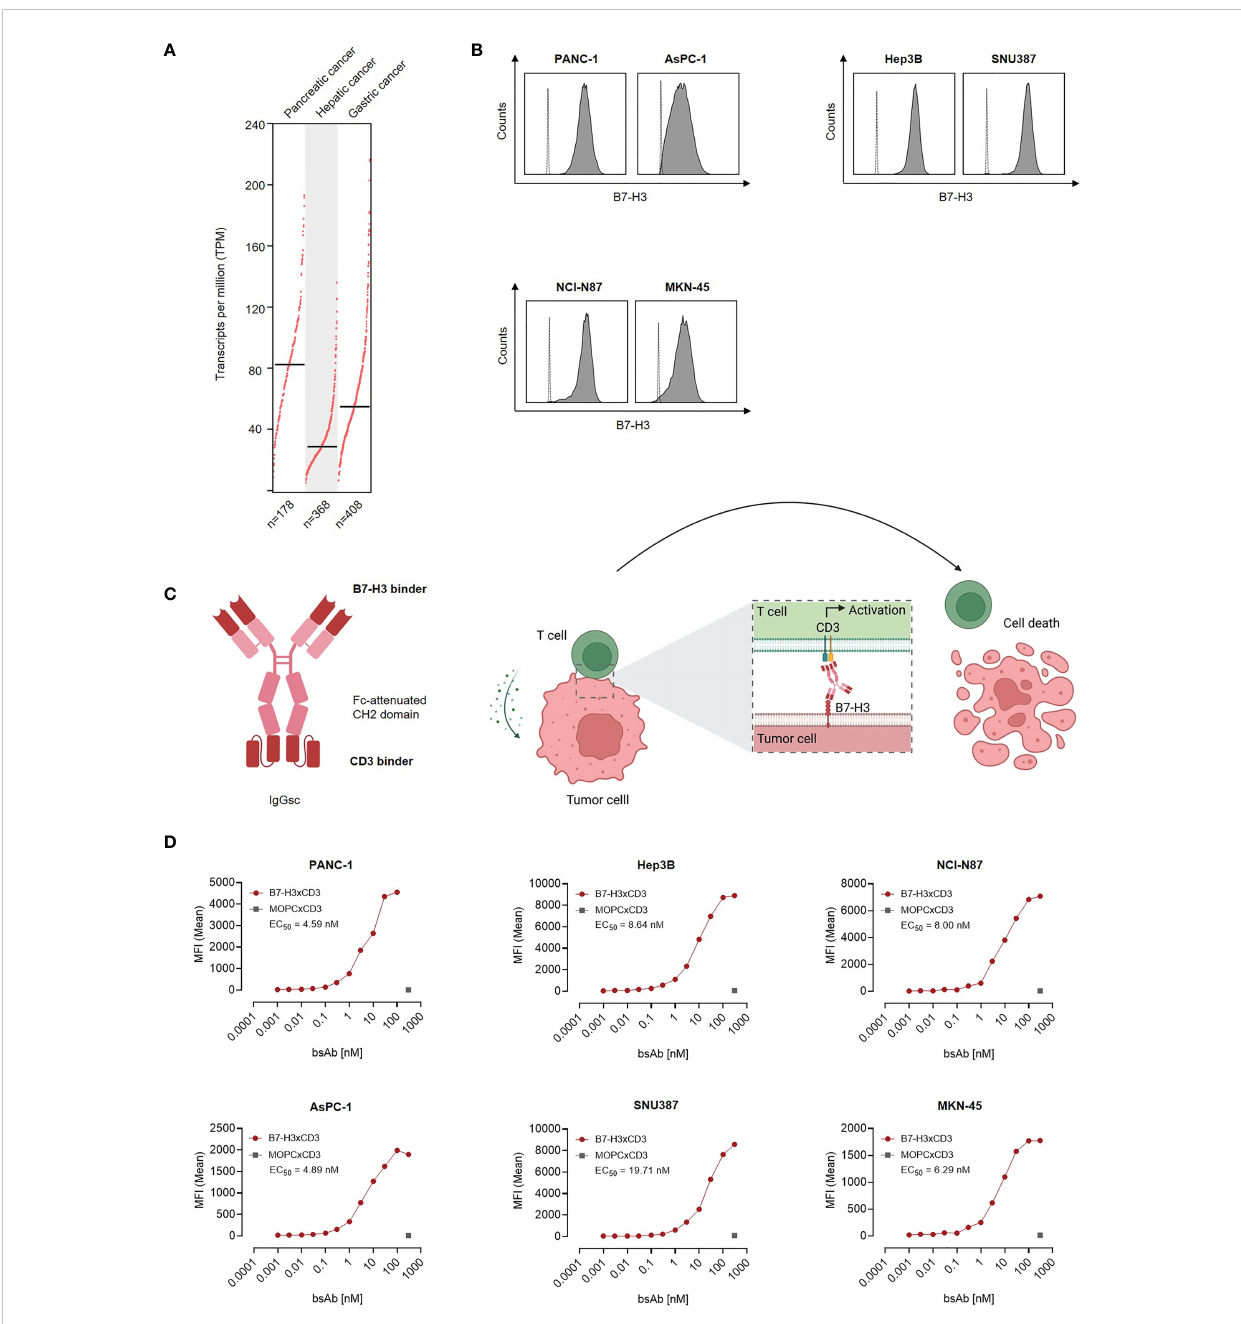
FIGURE 1 Characterization of B7-H3 expression and binding of CC-3 in gastrointestinal cancer cell lines. (A) CD276 gene expression pro fi le in pancreatic, hepatic and gastric cancer was analyzed using the online web server GEPIA. (B) The indicated cancer cell lines were stained using a murine monoclonal B7-H3 antibody (clone 7C4) followed by an anti-mouse PE conjugate and analyzed using fl ow cytometry. B7-H3 expression on pancreatic cell lines AsPC-1 and PANC-1, hepatic cell lines Hep3B and SNU-387 and gastric cell lines MKN-45 and NCI-N87 is shown (shaded peaks, anti-B7H3; open peaks, control). (C) Schematic illustration and mechanism of action of the B7-H3xCD3 bsAb CC-3. The graphic was created by BioRender (BioRender.com, Toronto, Canada). (D) The indicated tumor cells were incubated with increasing concentrations of CC-3 or the respective isotype control MOPCxCD3, followed by an anti-human PE conjugate. Binding of the constructs to the indicated cell lines was analyzed by fl ow cytometry. MFI, mean fl uorescence